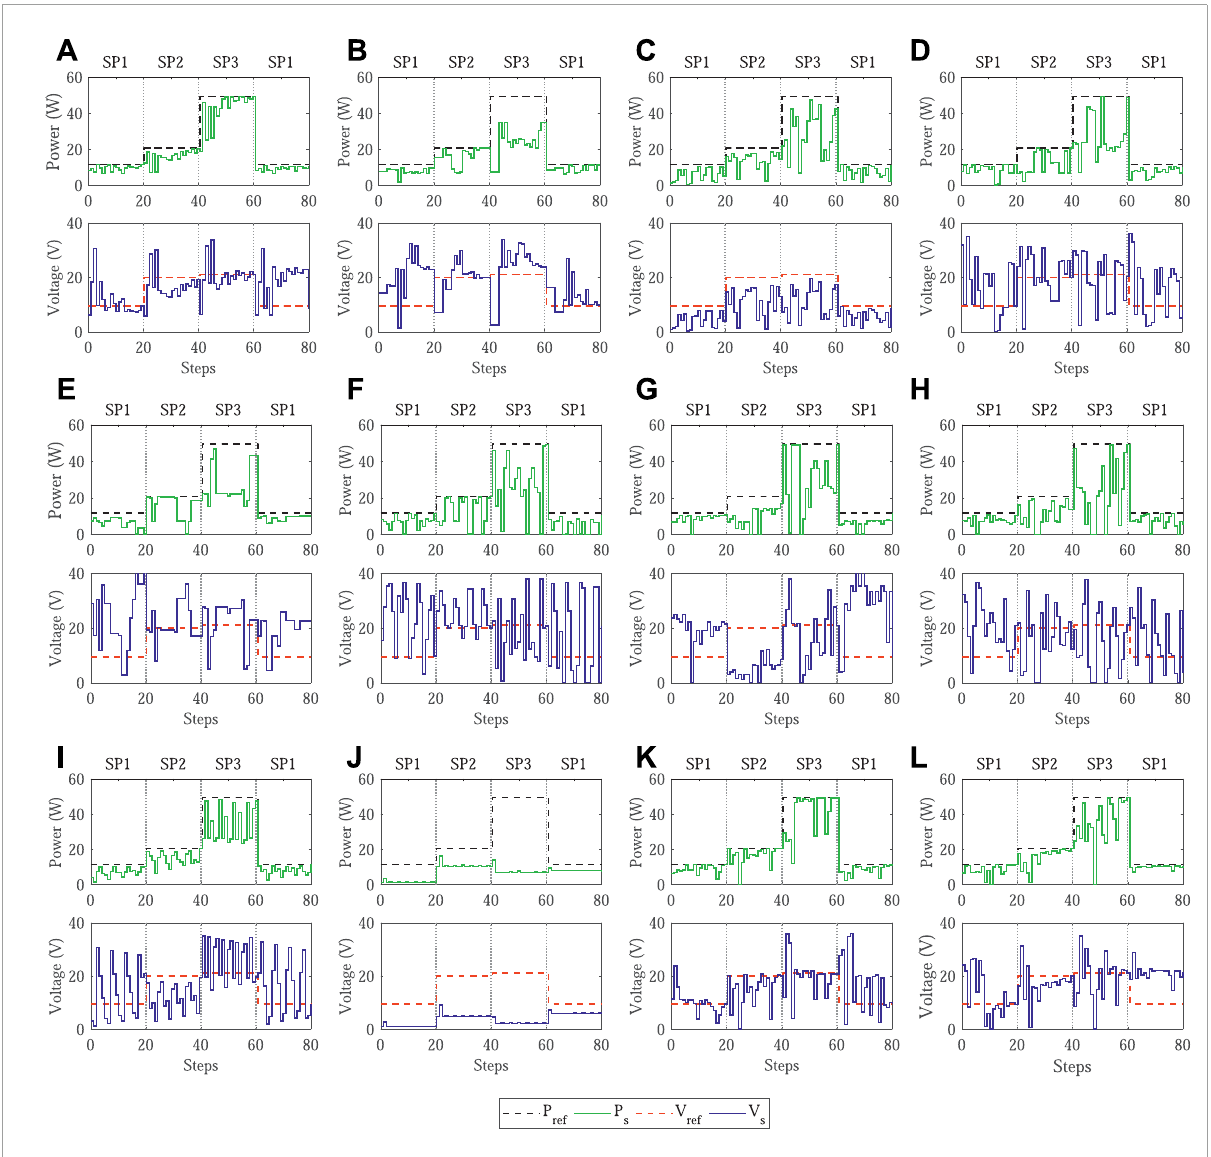
FIGURE 10 The power and voltage tracking trajectories of the 12 different algorithms in the step test: (A) VVS; (B) VS; (C) ABCA; (D) CS; (E) FAO; (F) FPO; (G) HHO; (H) Jaya; (I) PSO; (J) SFLA; (K) TLBO; (L) WCA.